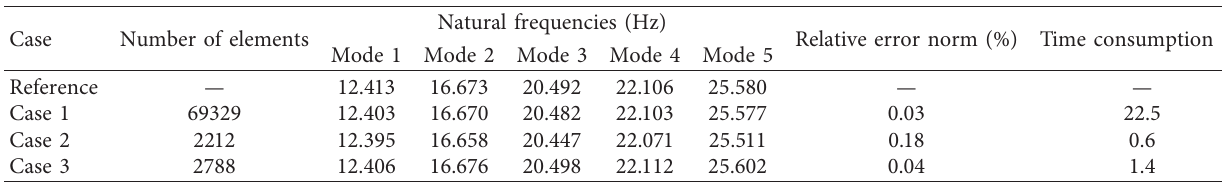
Table 4: The first five natural frequencies (Hz) of a simple CFRD.